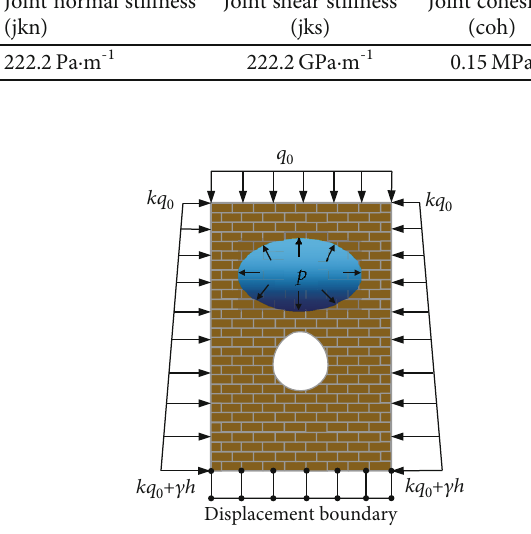
Figure 3: Boundary conditions of numerical simulation model.